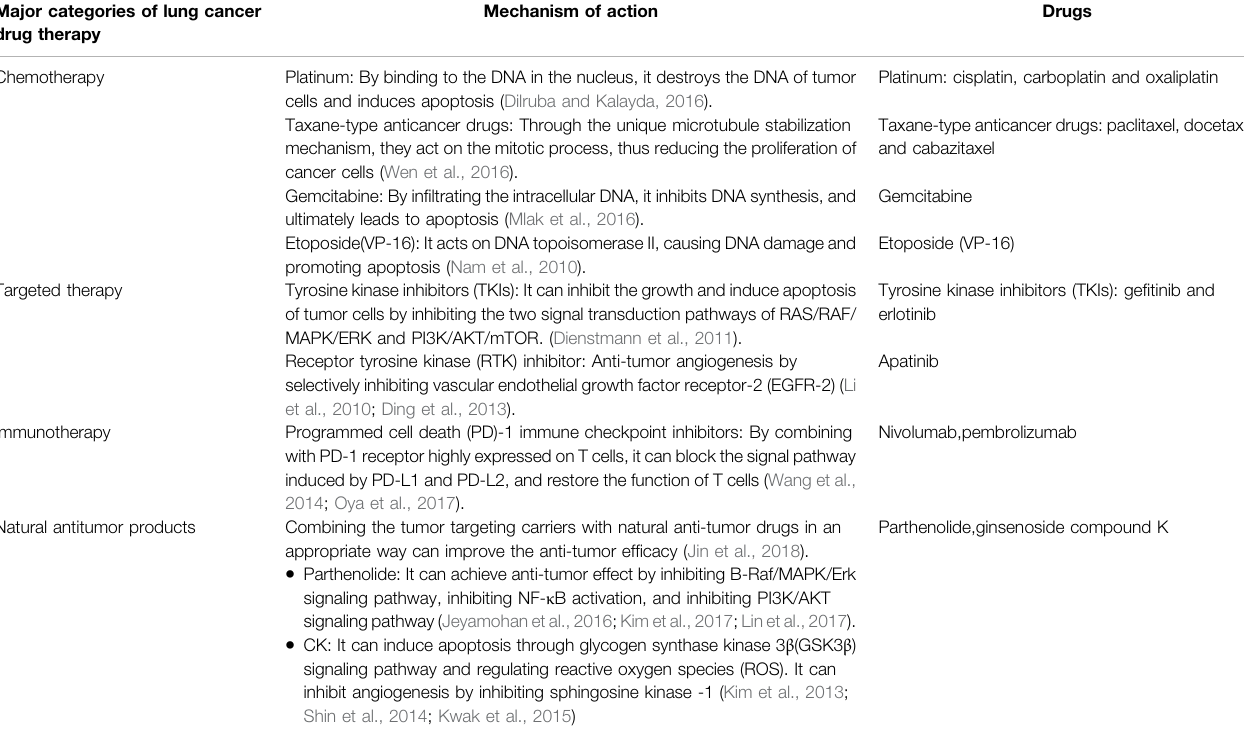
TABLE 2 | Some drugs and their mechanism of action in lung cancer